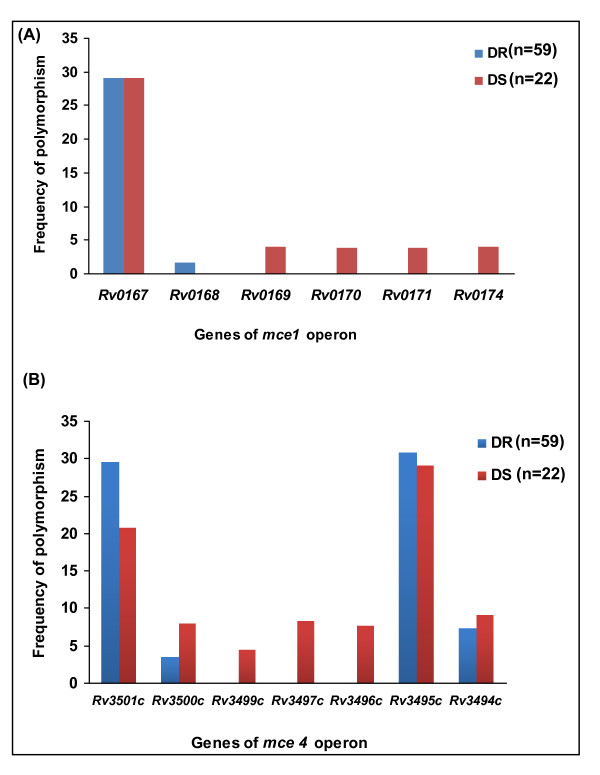
Comparative analysis of the frequency of SNPs in the mce operons genes of drug resistant (DR) and drug sensitive (DS) clinical isolates. SNPs were explored using Sequenom MassARRAY platform. DR (n = 59) and DS (n = 22) clinical isolates of M. tuberculosis were taken up for this study. The comparison between the two categories revealed that (A) mce1 and (B) mce4 operon genes were significantly more polymorphic in DS clinical isolates than DR isolates (*, p < 0.05) and (**, p < 0.01) respectively.